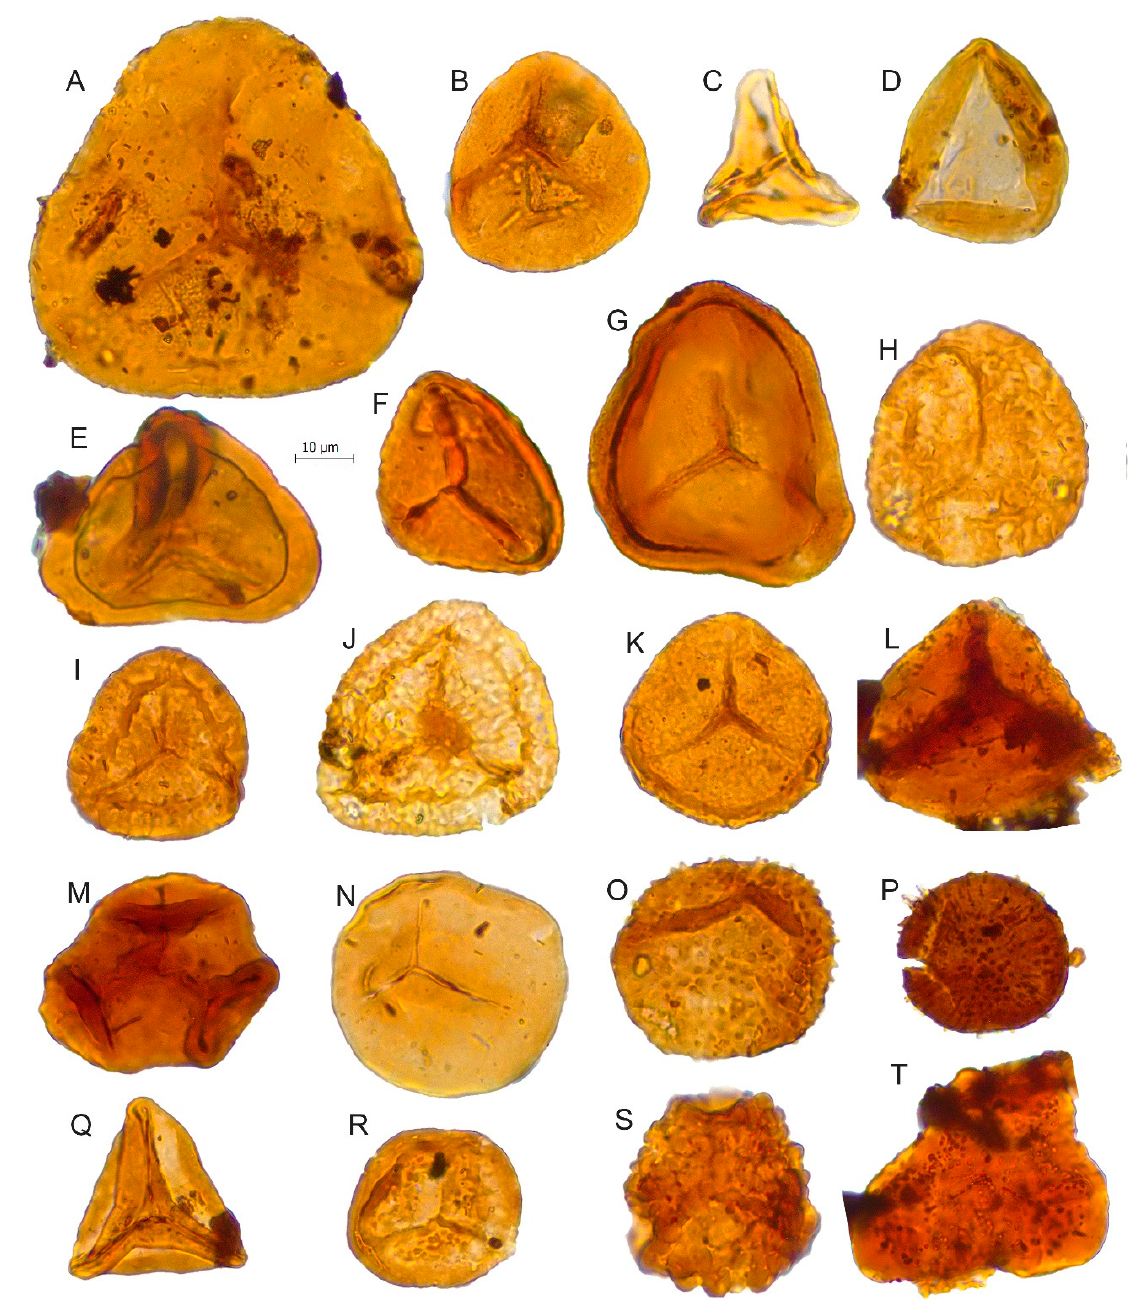
Figure 5. Scale bar: 10 µm. ( A ) Cyathidites australis , JVLP-2-4-H160; ( B ) Cyathidites minor , JCLP-B-4-O270; ( C ) Gleicheniidites senonicus, JVLP-C-2-T372; ( D ) Deltoidospora sp., JVLP-A-1-J054; ( E ) Murospora sp., JVLP-B-2-C281; ( F ) Matonisporites equiexinus , JVLP-3-1-D510; ( G ) Matonisporites sp., JVLP- 3-1-Q430; ( H ) cf. Camarazonosporites rudis , JVLP-3-1-J360; ( I ) Staplinisporites caminus , JVLP-3-1-G440; ( J ) Staplinisporites sp., JVLP-C-2-R280; ( K ) Stereisporites antiquasporites , JVLP-1-2-N470; ( L ) Bi- retisporites potoniaei, JVLP-A-1-N211; ( M ) Cibotiumspora jurienensis, JVLP-3-2-L240; ( N ) Todisporites